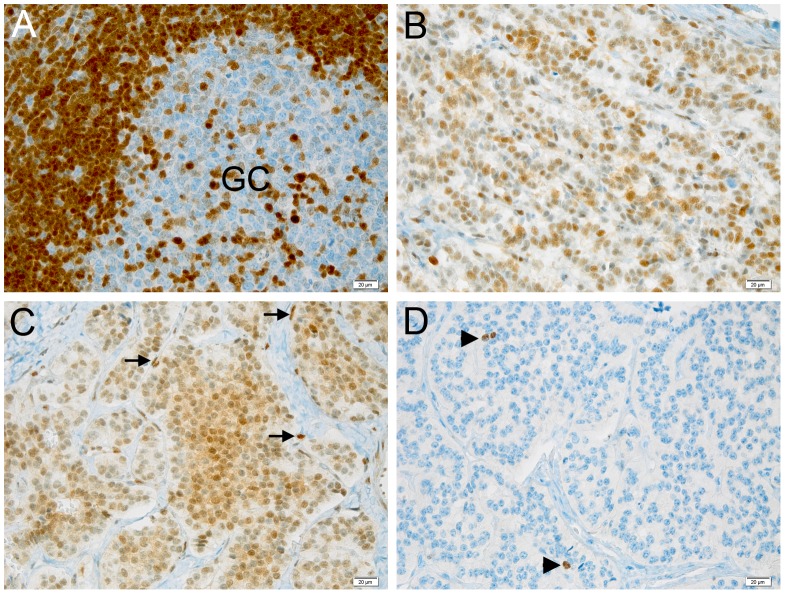
Expression of p27KIP1 and Ki-67 in pancreatic tumors and control tissue.(A–C) Immunohistochemical staining with anti-p27KIP1 antibody. (D) Staining with anti-Ki67 antibody. (A) staining of a control human tonsil. Cells in the lymphatic nodule show the expected strong nuclear positivity for p27KIP1, while only few of the highly proliferating germinal center (GC) cells express p27KIP1. (B) Sporadic endocrine pancreatic tumor of an individual with no known germline mutations. The tumor cells show intermediate levels of nuclear immunoreactivity for p27KIP1. (C) Endocrine pancreatic tumor of the patient having the c.-456_-453delCCTT mutation. Tumor cells show low expression of p27KIP1 in the nucleus but also expression in the cytoplasm. Endothelial cells (arrows) show the typical strong nuclear positivity and serve as internal control to check for the adequacy of the staining. (D) Same tissue as in C stained for the proliferation marker Ki-67. Positive nuclei are indicated with arrowheads. The proliferation rate was estimated to be ca. 1%. Bar, 20 µM. Original magnification: A–D, 200×.